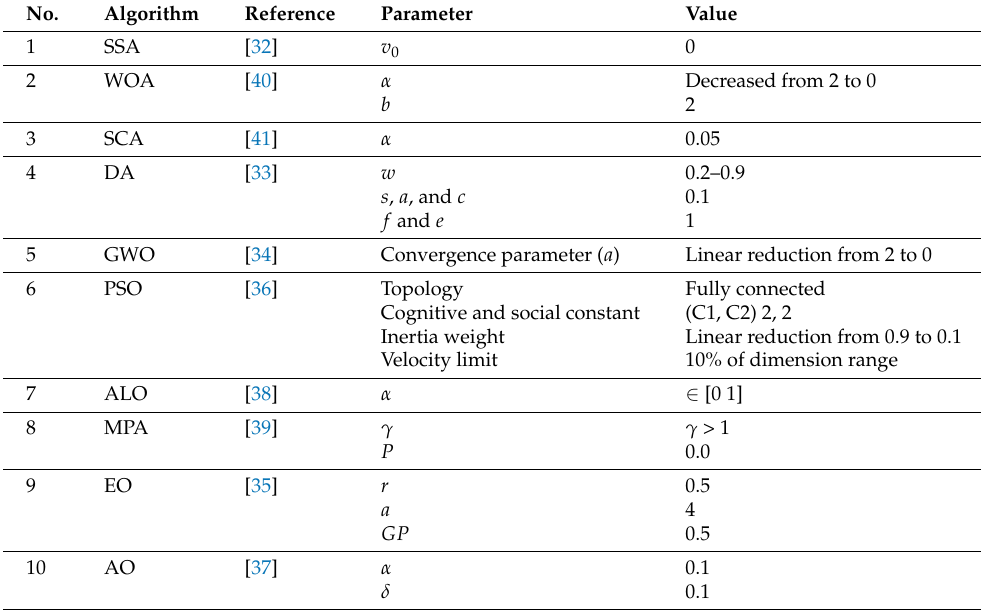
Table 1. Setting of the comparative methods’ parameters.